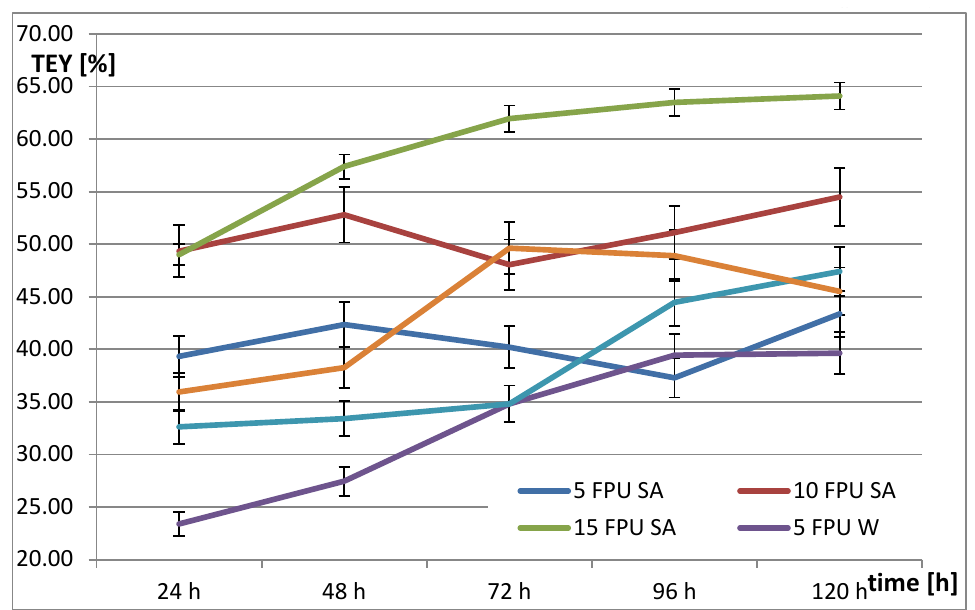
Figure 4. Theoretical ethanol yield (TEY) from rye straw treated with 2% sulfuric acid at 121 °C and 1 h after enzymatic hydrolysis (SA—Sulphuric acid, W—Water)